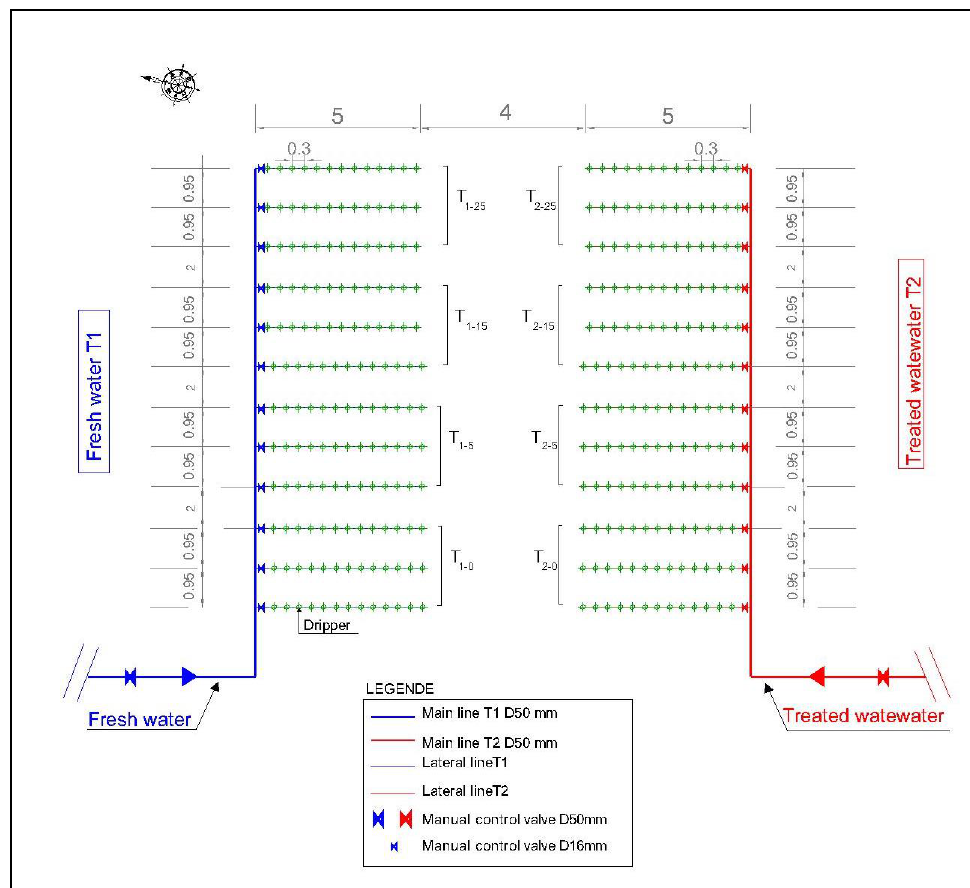
Figure 1. Experimental layout.